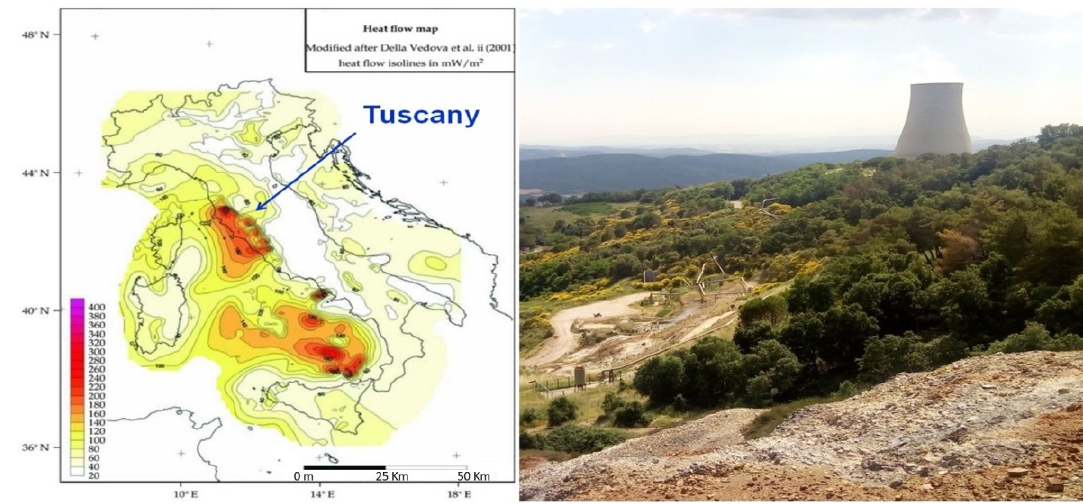
Figure 1. Heat flow distribution (modified after [29]) and cooling towers near Parco delle Biancane site.